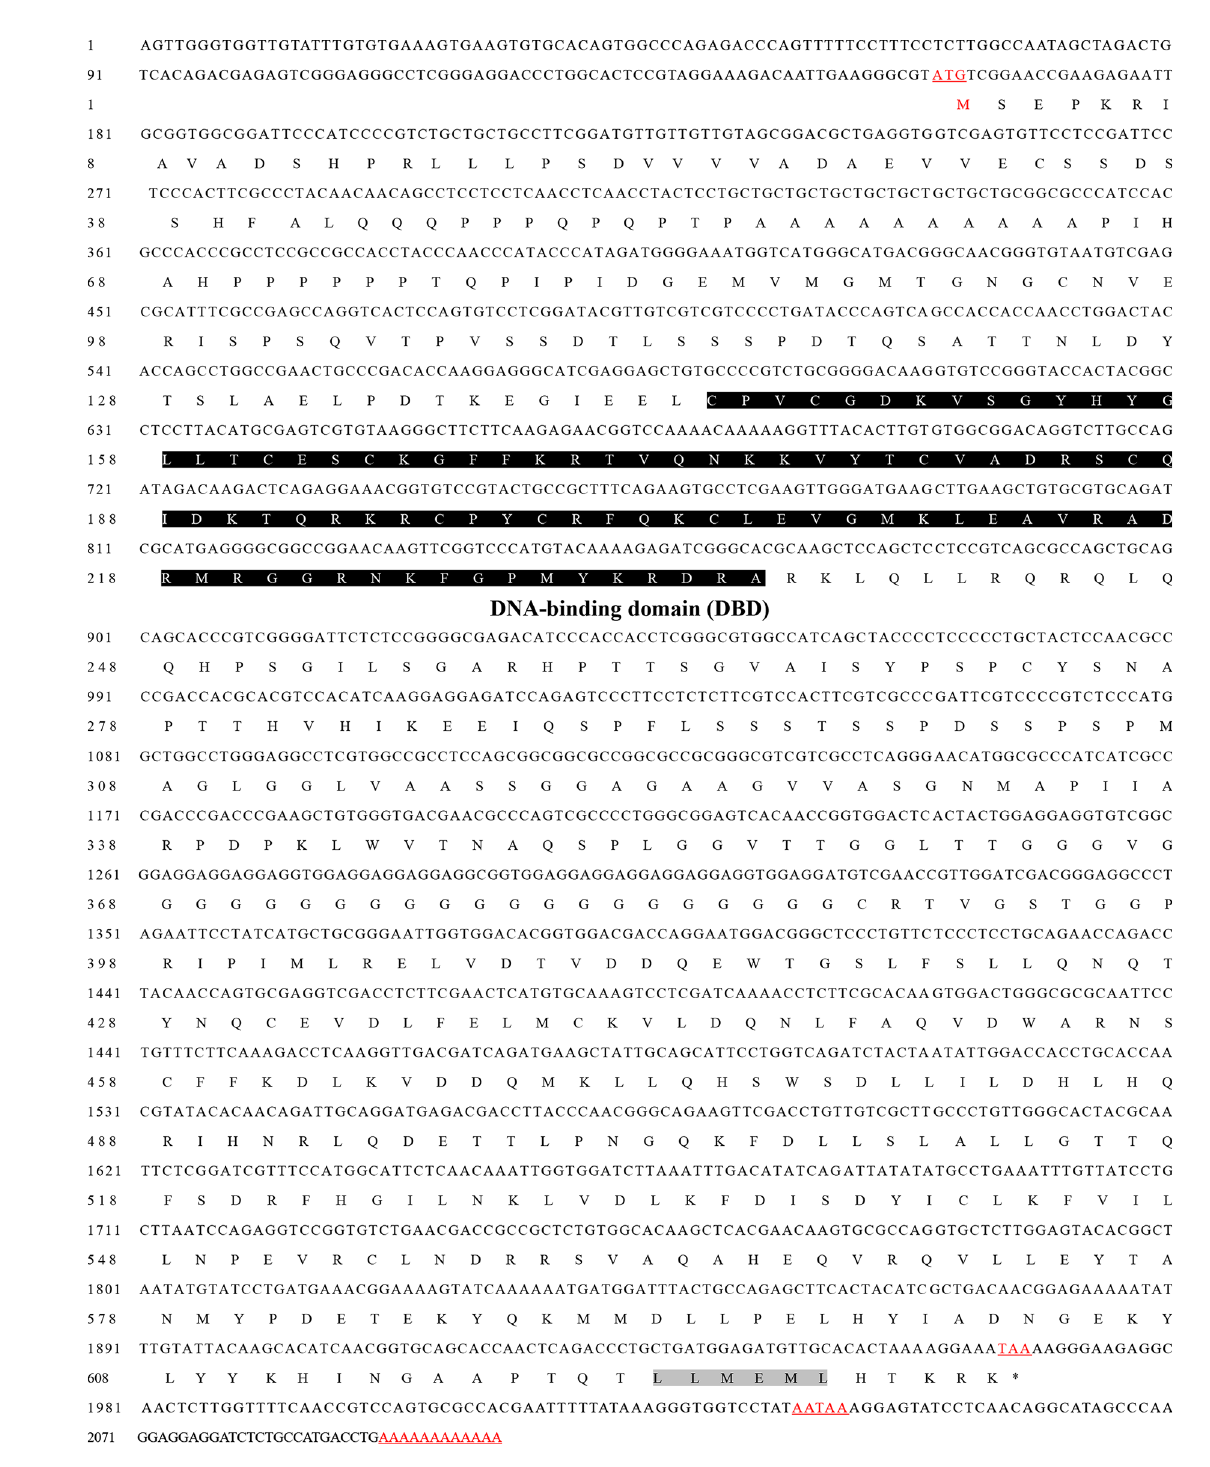
Frontiers in Endocrinology |